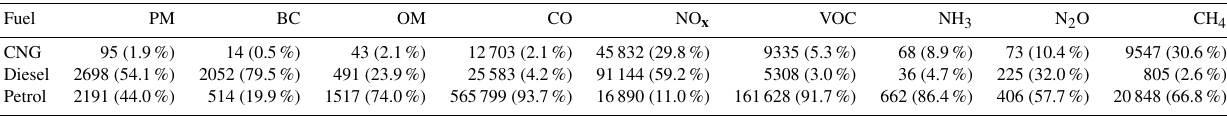
Table 3. Emission in kgd − 1 (% share) according to fuel type. Fuel